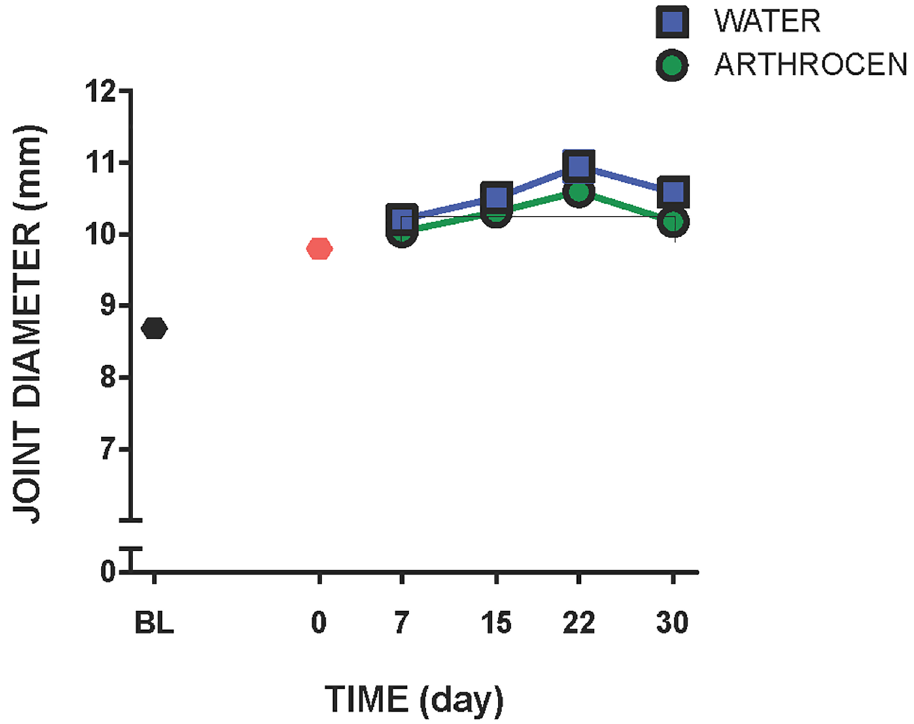
Fig 1. Change in joint diameter in vehicle and Arthrocen-treated OA rats. Over the 30 day test period, Arthrocen attenuated the increase in joint diameter caused by MIA injection. Data are means ± S.E.M. (Fig 2B; P < 0.0001; n = 9–11). Arthrocen did not alter paw surface area (P = 0.07), but did